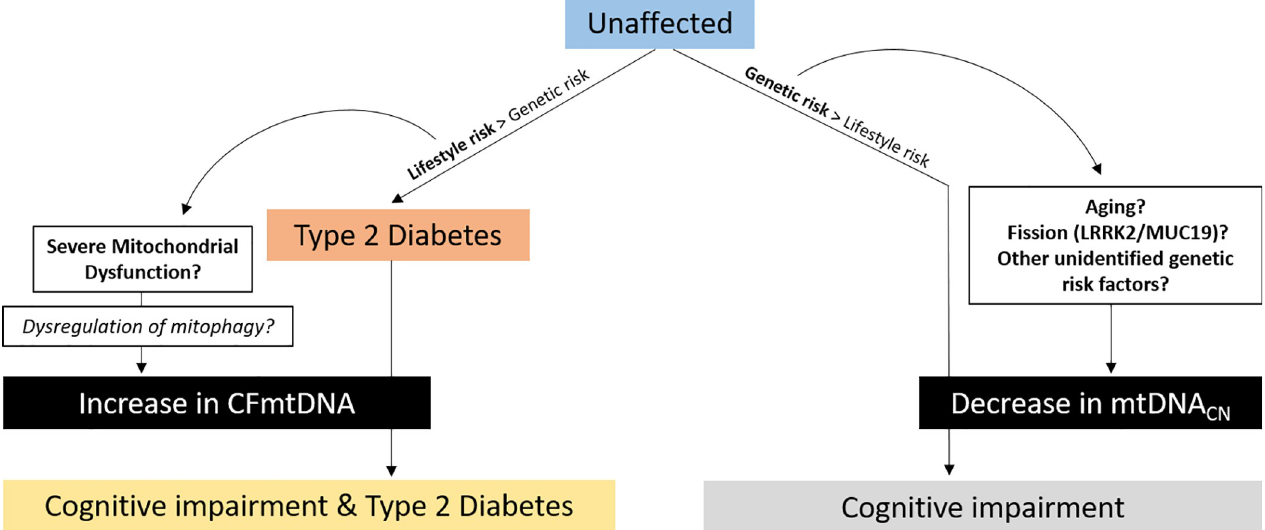
Fig 10. Hypothetical schematic for biological context of results. Type 2 diabetes is often considered to be a disease of lifestyle, while cognitive impairment ( e . g ., Alzheimer’s Disease) is presumed to be more founded in genetics, based on higher estimates of heritability. Increased CFmtDNA observed in subjects with both CI and T2D may be the result of lifestyle-sourced mitochondrial dysfunction, ultimately impacting mitophagy and resulting in release of mitochondrial components extracellularly. Decrease mtDNA CN was a more prominent feature in subjects with CI only. Genetic risk factors affecting mitochondrial dynamics and/or aging may underlie this trend.